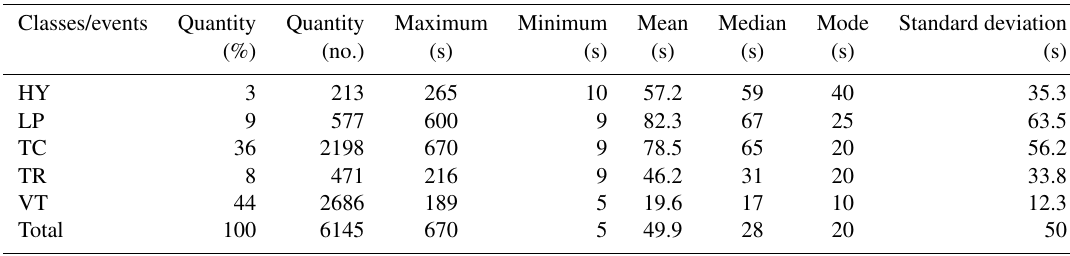
Table 2. Statistics of the seismic records, based on the majority of the records.